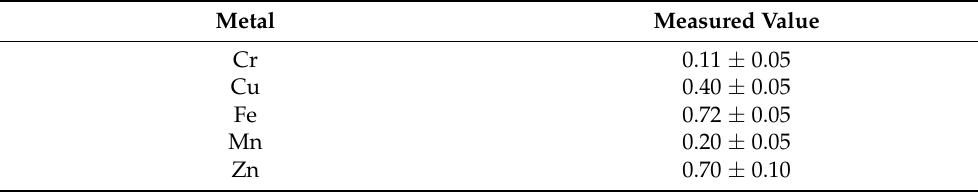
Table 4. Metal concentrations in field blank sample ( µ g L − 1 ± σ ; n = 3) a